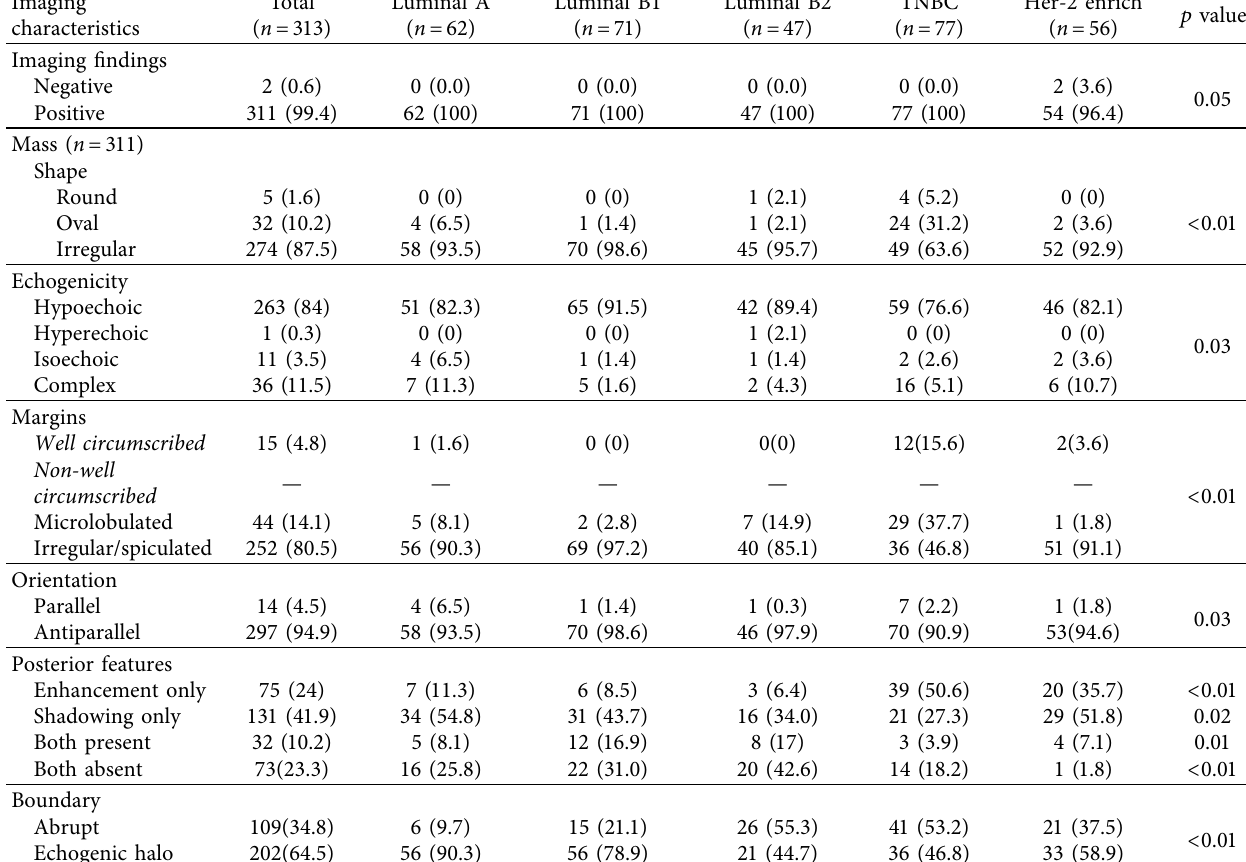
Table 3: Ultrasound findings.